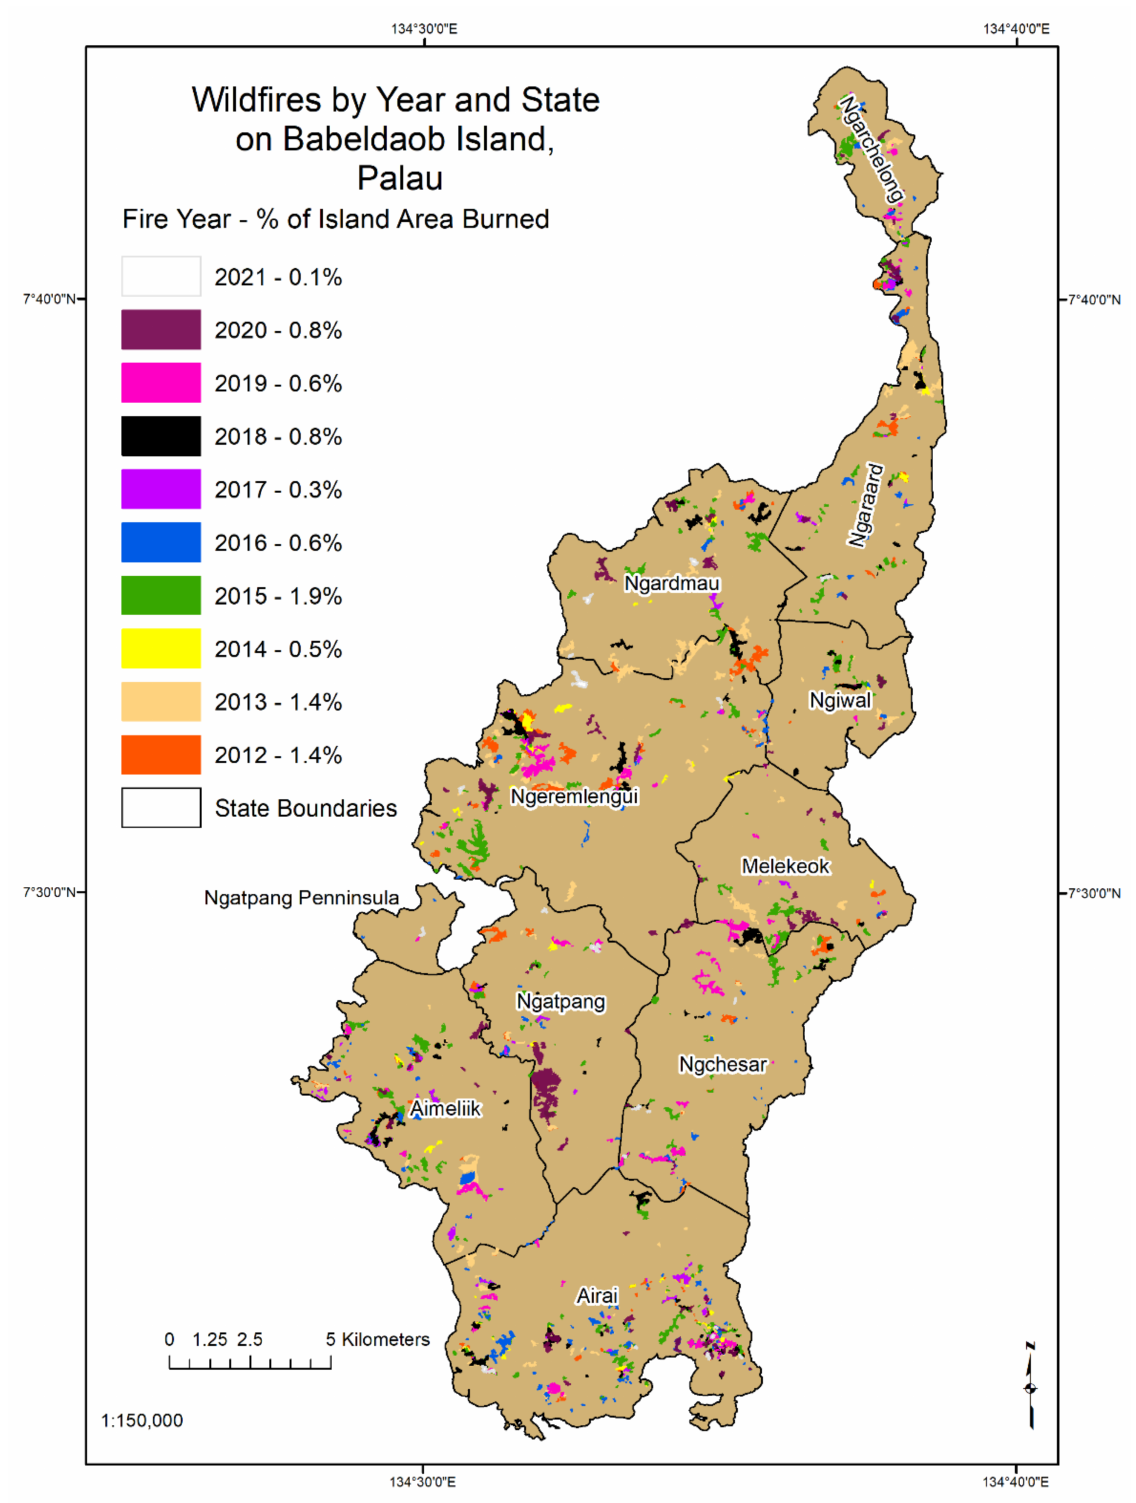
Figure 3. Annual wildfires and percentage of island area burned on Babeldaob Island, from 2012 to 2021. Some older burned areas are obscured by more recent burned